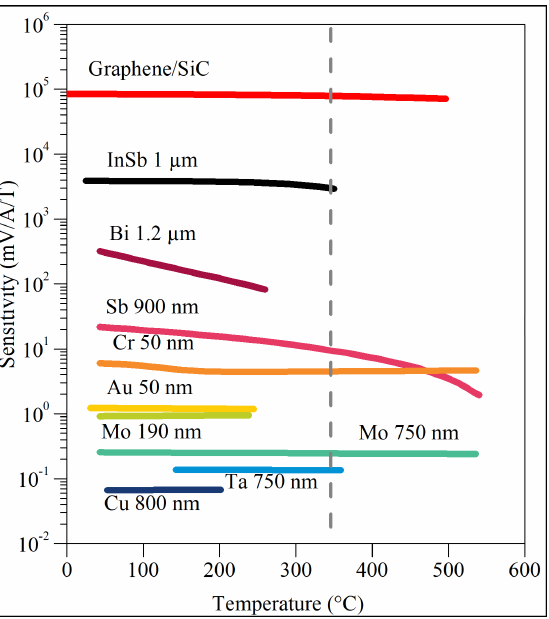
Figure 7. The sensitivity chart of GR/SiC and InSb-based structures in a wide temperature range. The sensitivity waveforms of other structures are based on the data from Refs. [5,42] and are shown for comparison.